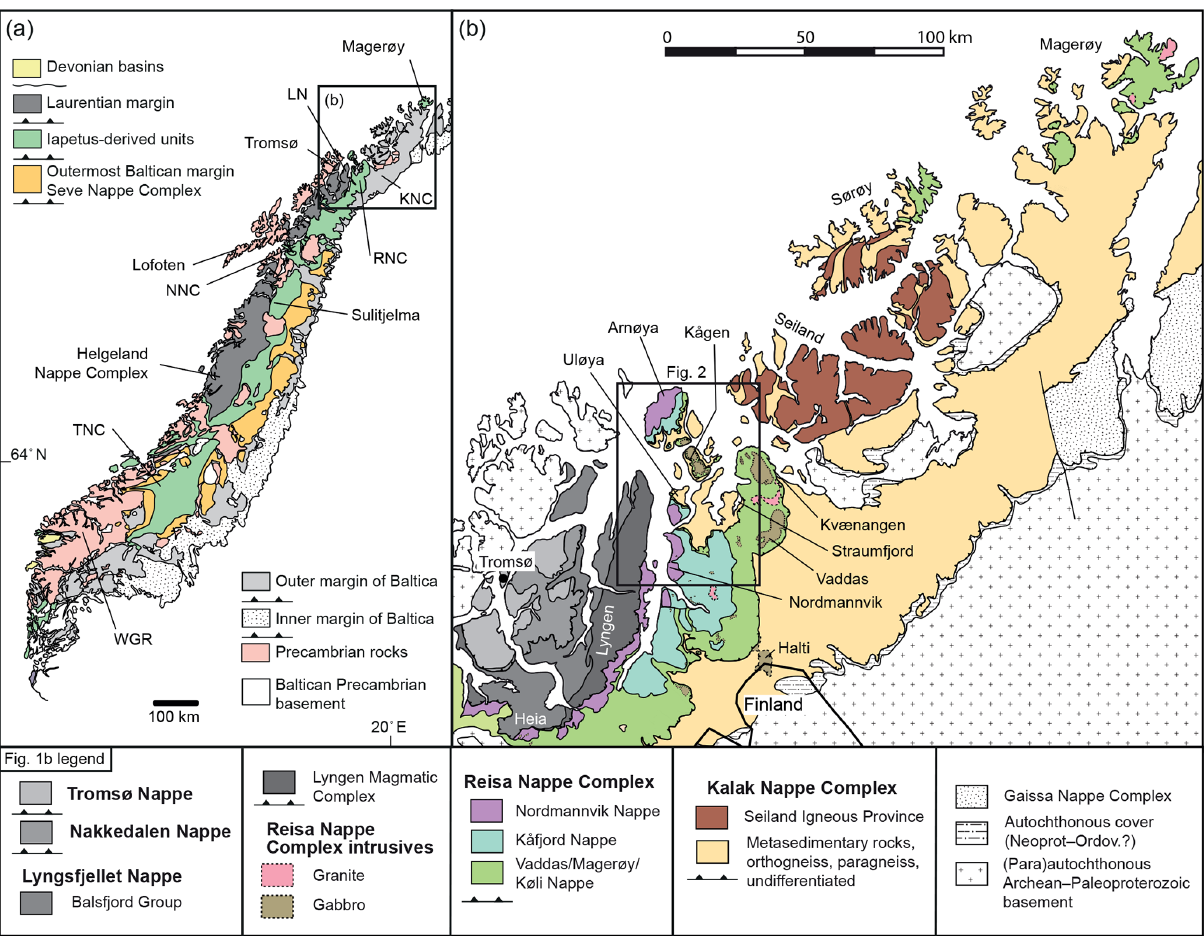
Figure 1. (a) Simplified map of the Scandinavian Caledonides and their inferred palaeotectonic origin, modified from Gee et al. (2010). LN is the Lyngsfjellet Nappe, WGR is the Western Gneiss Region, NNC is the Narvik Nappe Complex, KNC is the Kalak Nappe Complex, RNC is the Reisa Nappe Complex, and TNC is the Trondheim Nappe Complex. (b) Map showing the extent of the Reisa Nappe Complex in northern Norway, based on Zwaan (1988) and own correlations. The Vaddas, Kåfjord, and Nordmannvik nappes are shown in colour. The study area is denoted by the black box (Fig.